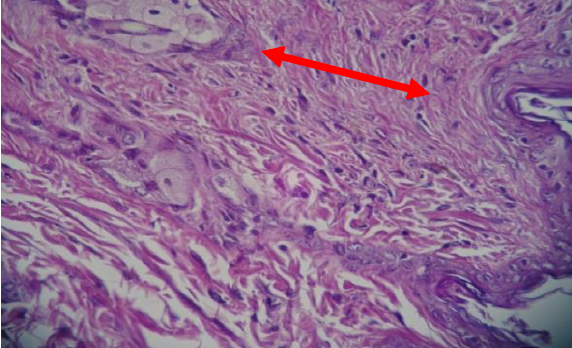
Figure,13: Section in skin of immunized animal at day 30 post challenge showed fibrotic and granulated tissue with moderate MNCs infiltration (H&E Stain400X).